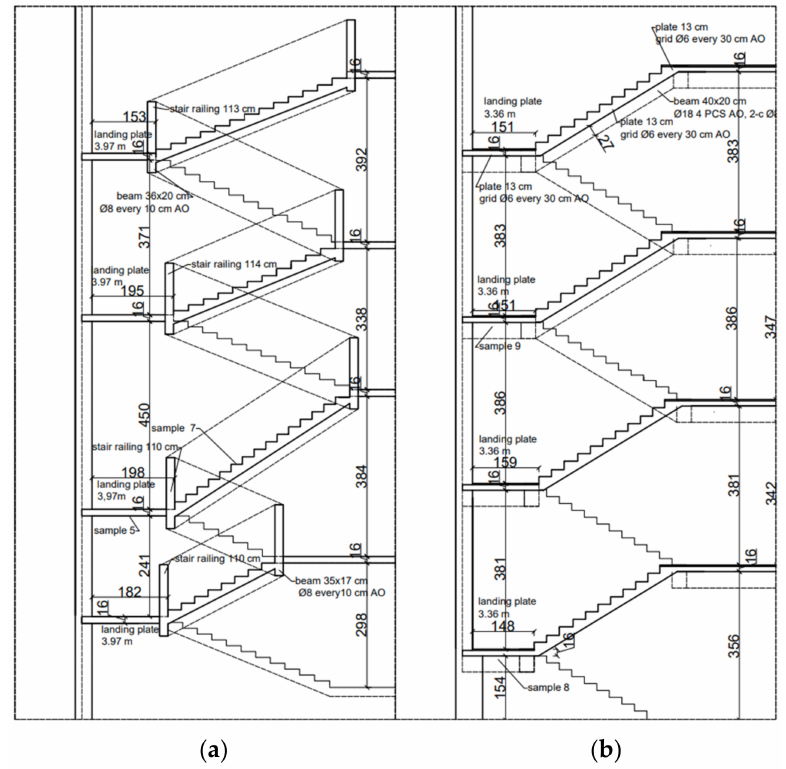
Figure 2. A view of staircases ( a ) staircase K1, ( b ) staircase K2.